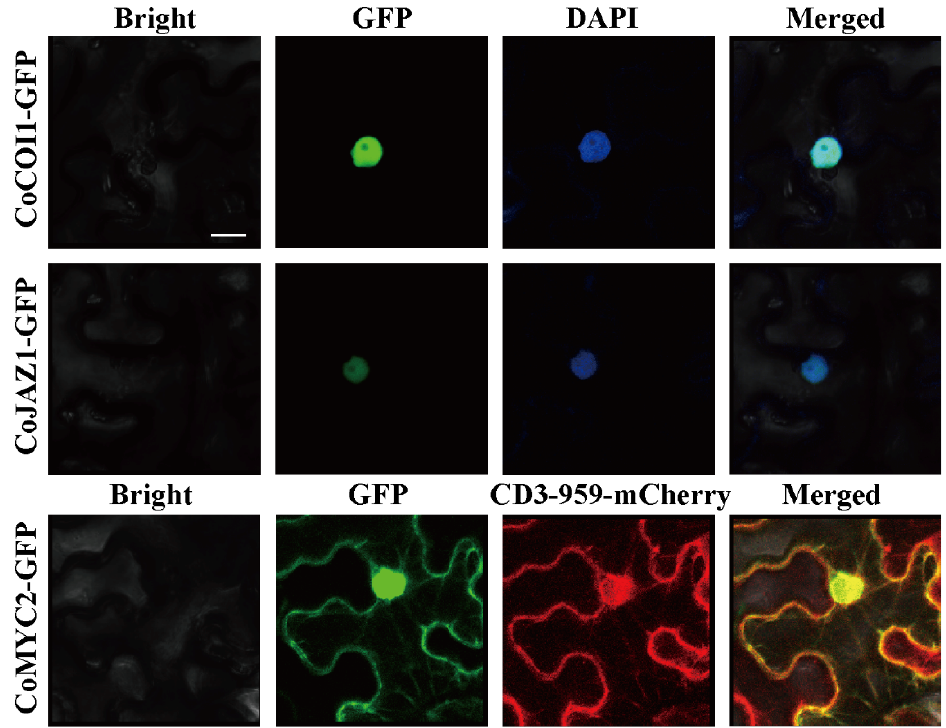
Figure 3. Subcellular localization of CoCOI1/CoJAZ1/CoMYC2 in Nicotiana benthamiana . GV3101 containing the mentioned genes were infiltrated in the leaves of N. benthamiana , and the expression was detected with a laser confocal microscope 48 h later. Bar = 10 μ m.